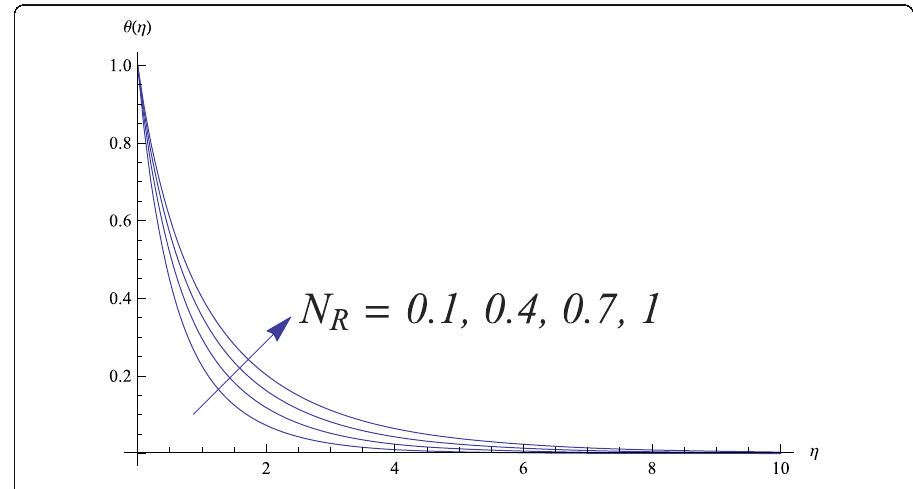
Fig. 3 Variation of fluid temperature with N R , for A = − 1, Pr = 0.7, U 0 = 1, f 0 = −